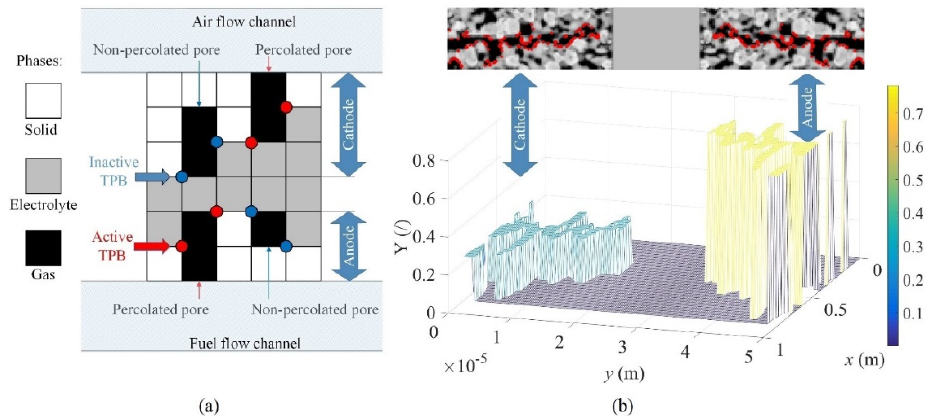
Figure 5. ( a ) Schematic explanation of the detection of active triple phase boundary (TPB) and ( b ) percolated gas phases.